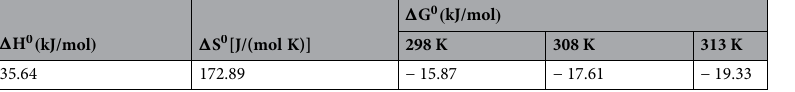
Table 3. Thermodynamic parameters for the U(VI) adsorption onto Fe 3 O 4 @SiO 2 @UiO-66-TPP NPs.